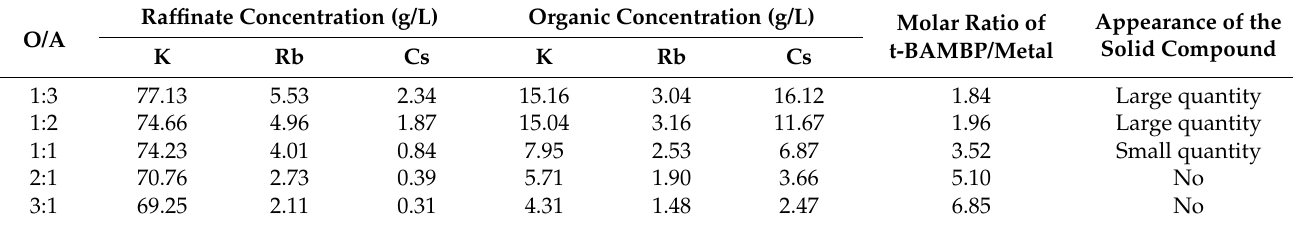
Table 3. States of organic phases under different t-BAMBP/metal molar